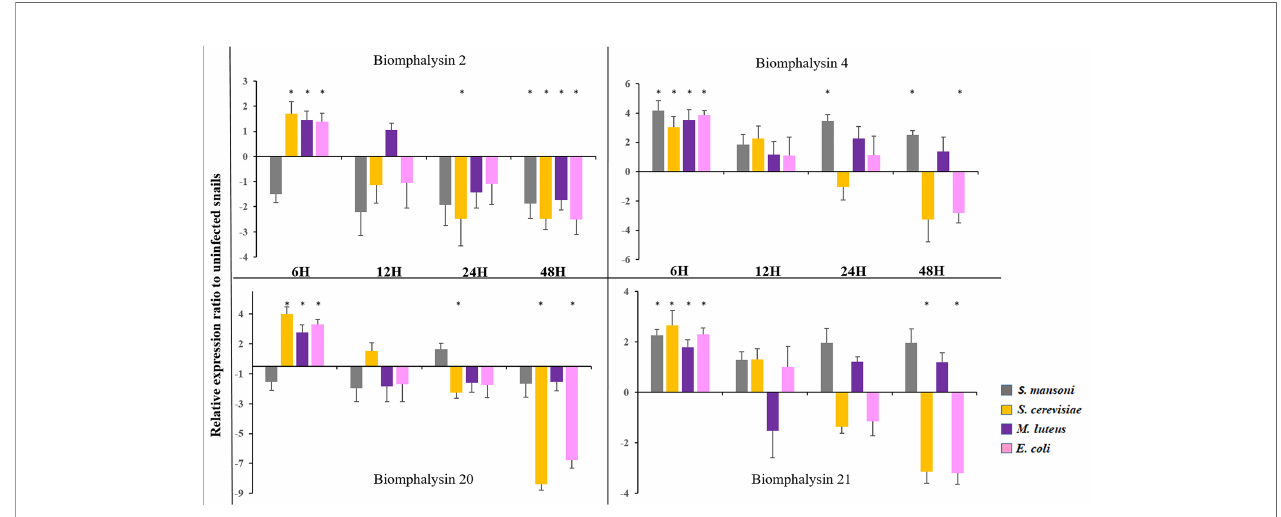
FIGURE 8 | Expression of Biomphalysin 2, 4, 20 and 21 Expression of biomphalysins was monitored 6, 12, 24 and 48 h after immune challenge with Schistosoma mansoni (gray), Saccharomyces cerevisiae (orange), Micrococcus luteus (purple) and Escherichia coli (pink). Expression normalization was done using the S19 housekeeping gene for each experimental point. Data are represented as mean 2 - DD Ct in challenged snails relative to unexposed snails. Values of 2 - DD Ct less than 1 were transformed for a better visualization as follow: -1/(2 - DD Ct ). * indicates a signi fi cant over- or under-expression in challenged condition compared to control (Mann-Whitney U test, p < 0.005).